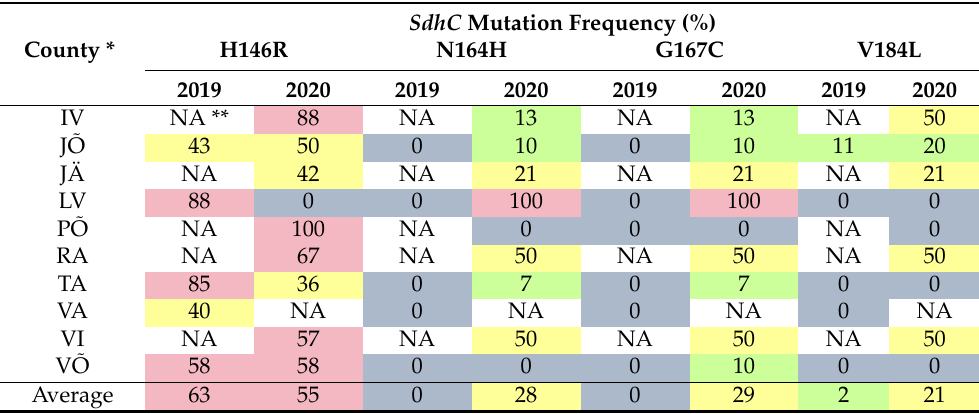
Table 3. Mutation frequencies (%) in SdhC gene in R. collo-cygni population from Estonia in 2019 and 2020. Frequencies between 1 ‒ 20% are indicated in green, 21 ‒ 50% are yellow, 51 ‒ 100% are pink, missing mutations (0%) are grey.